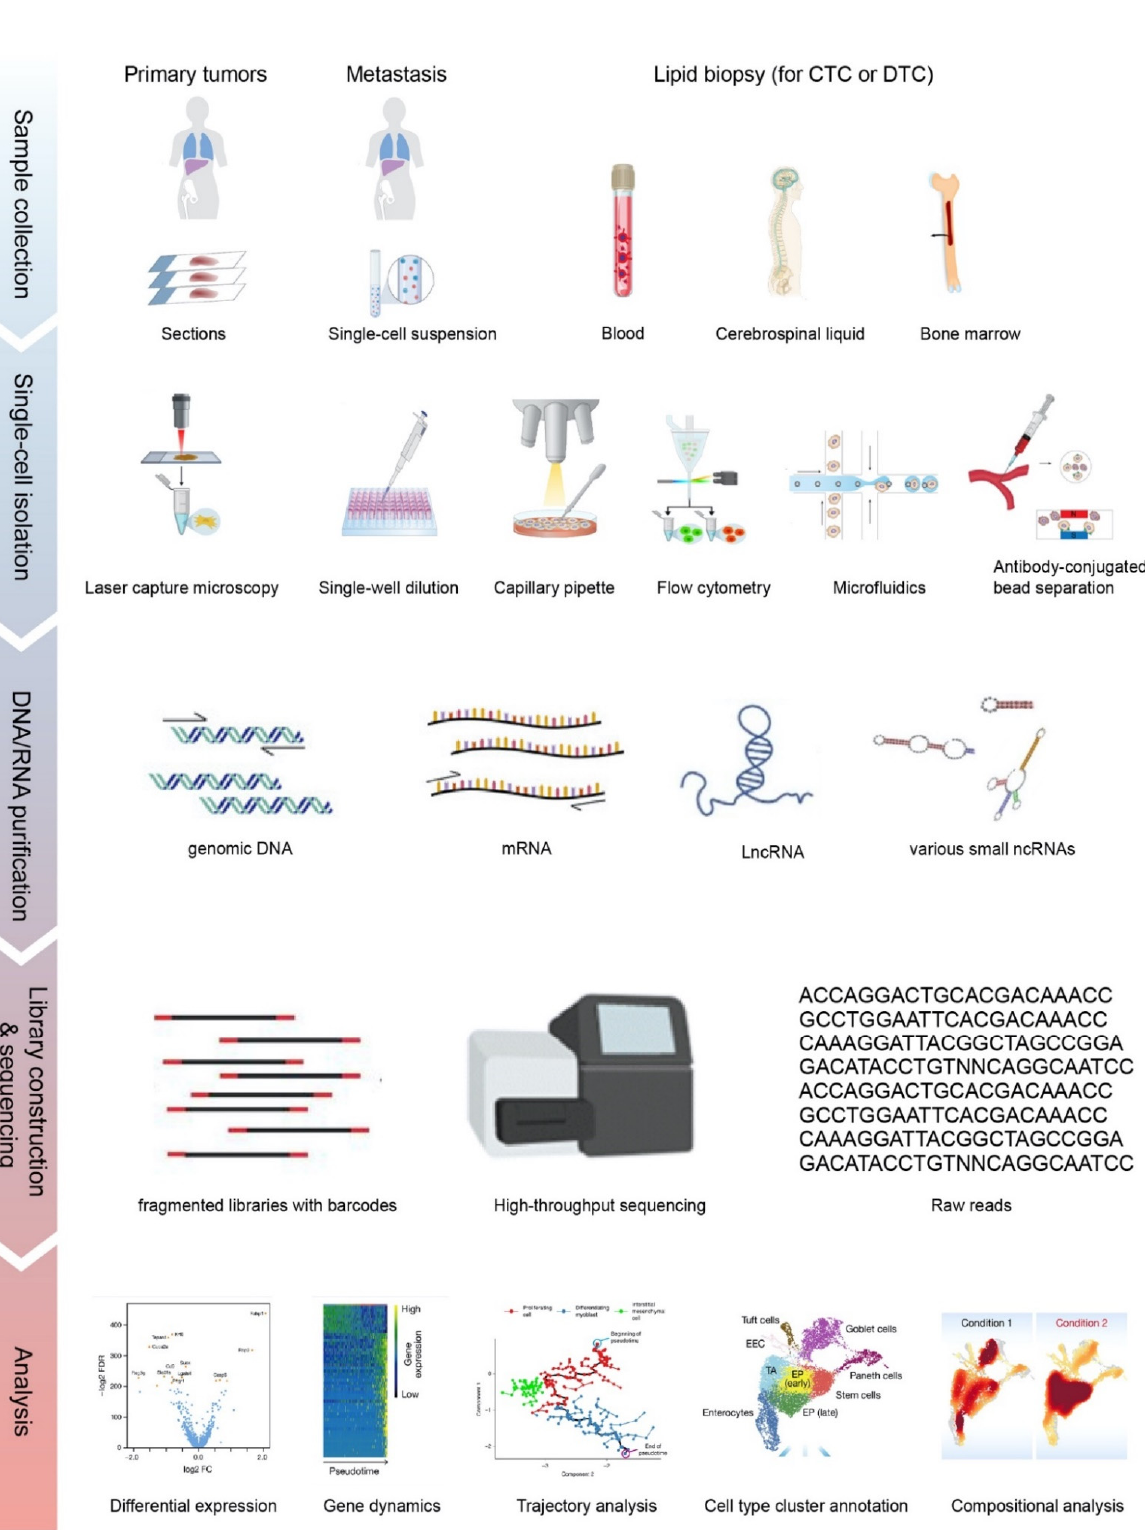
Figure 1. The overall workflow of single-cell sequencing (SCS). Single cells are isolated from solid tissues or liquid biopsies via different approaches. Libraries generated from purified nucleic acids are sequenced on the 2nd or 3rd generation sequencing platforms. Raw reads are processed and visualized as shown in different applications in the Analysis section, including marker gene selection by differential expression, pseudotime tracking by trajectory analysis and cell type cluster to elucidate the population. Parts of the subplots are adapted from the figures in the reference literature [11–13]. CTC: circulating tumor cell; DTC: disseminated tumor